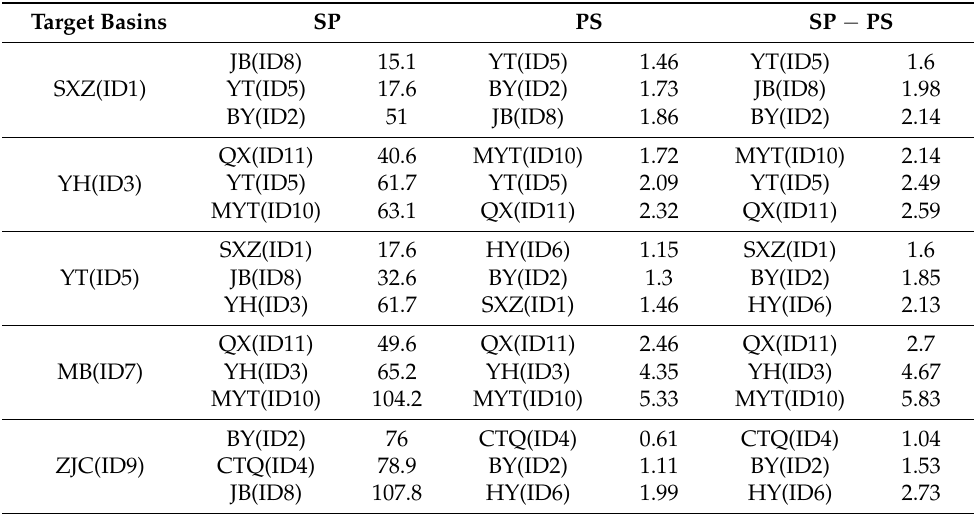
Table 6. Reference basins selected for each ungauged basin and their corresponding similarity values based on SP, PS, and SP −